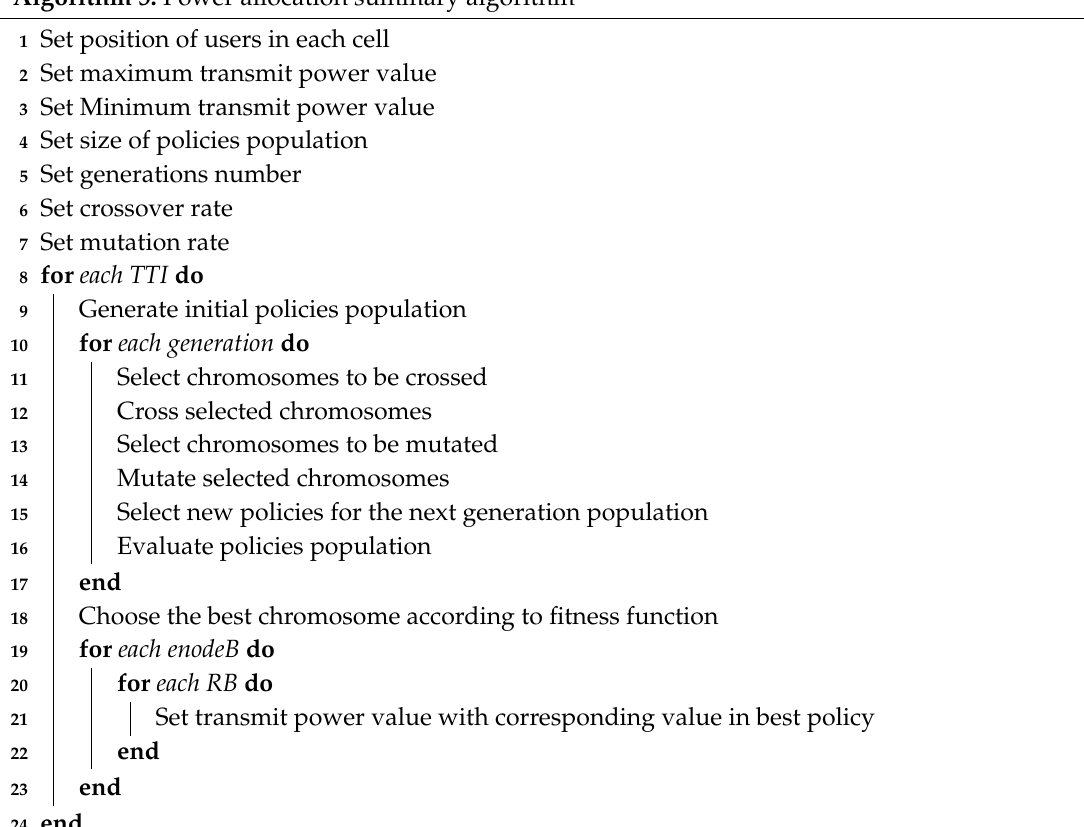
Algorithm 5: Power allocation summary